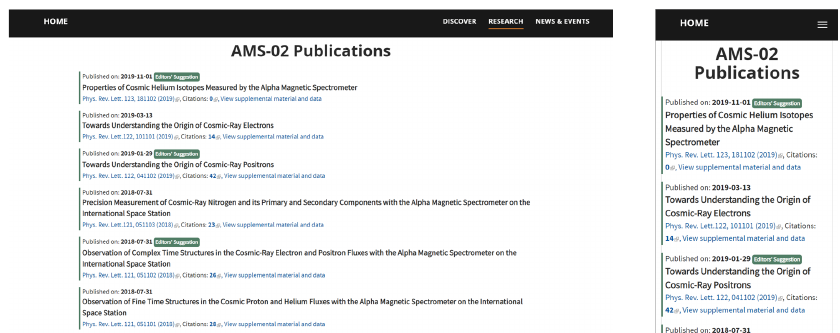
Figure 4. A comparison of the list of AMS publications displayed on a desktop computer and on a mobile phone. The Bootstrap grid system is used instead of the traditional HTML tables to implement responsive design. Visual element rendering is based on the screen